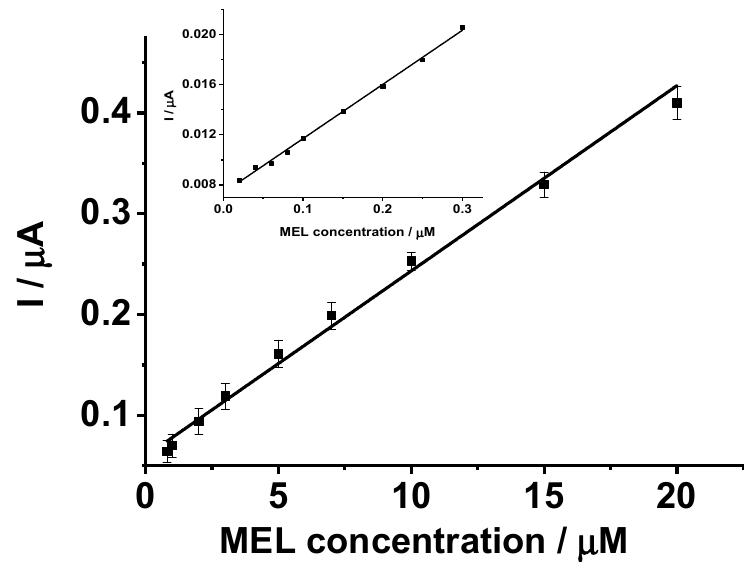
Figure 8. The calibration plot for the SNGCE/AuNP sensor including error bars for melatonin concentrations ranging from 0.5 to 20 µM. Inset: calibration plot for the concentration range from 0.02 to 0.3 µM.